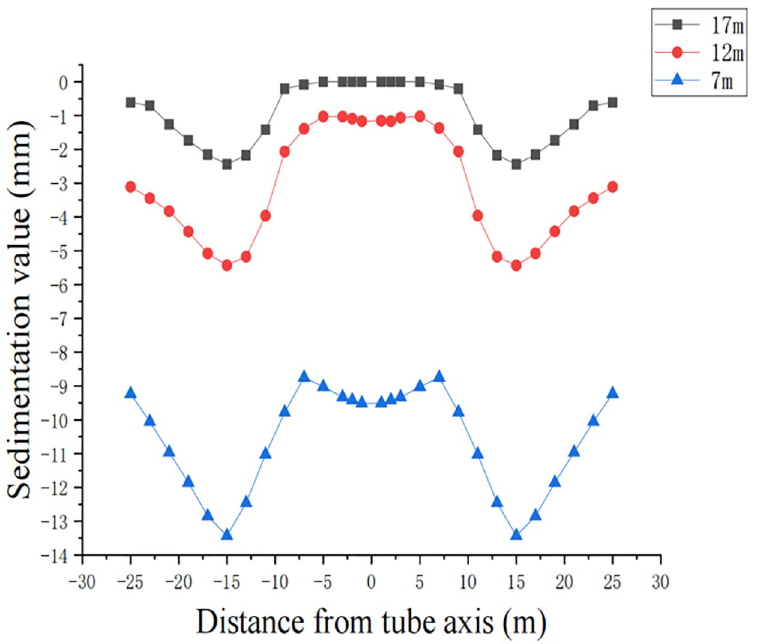
Fig 22. Surface settlement curves for different pipe jacking